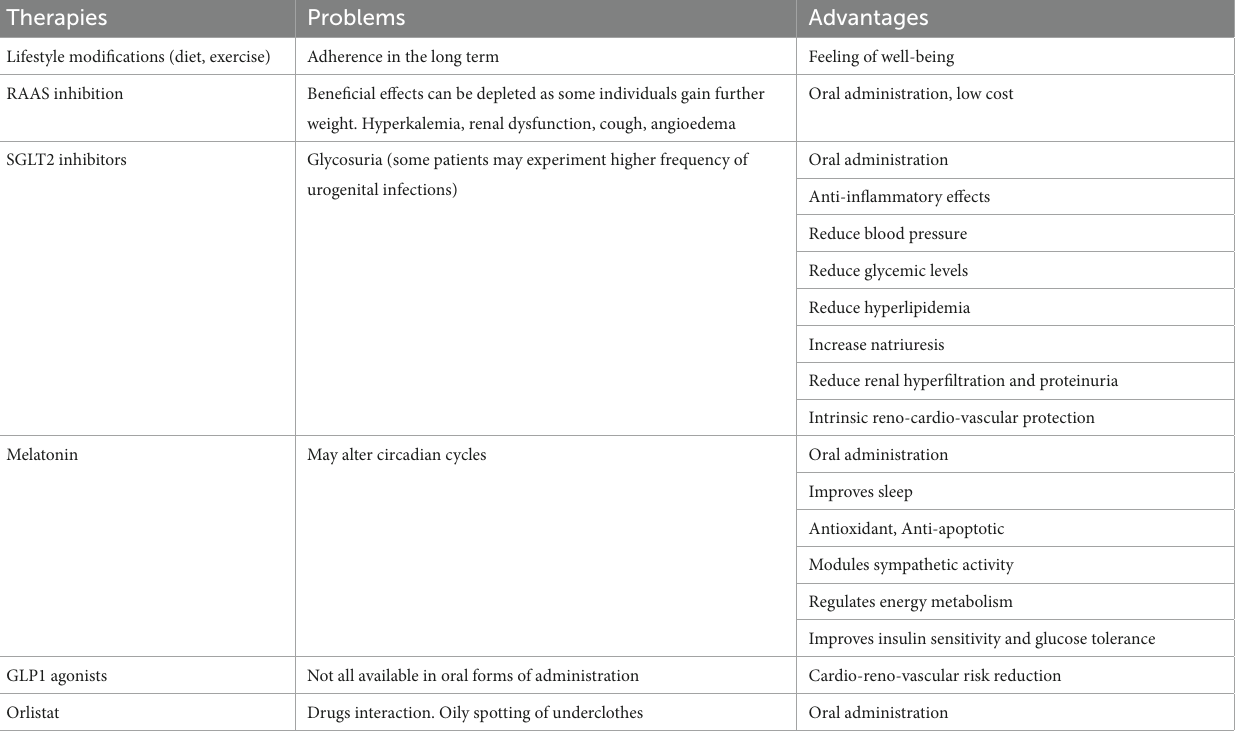
TABLE 2 Alternatives or complementary therapies to bariatric surgery in obese patients with CKD.